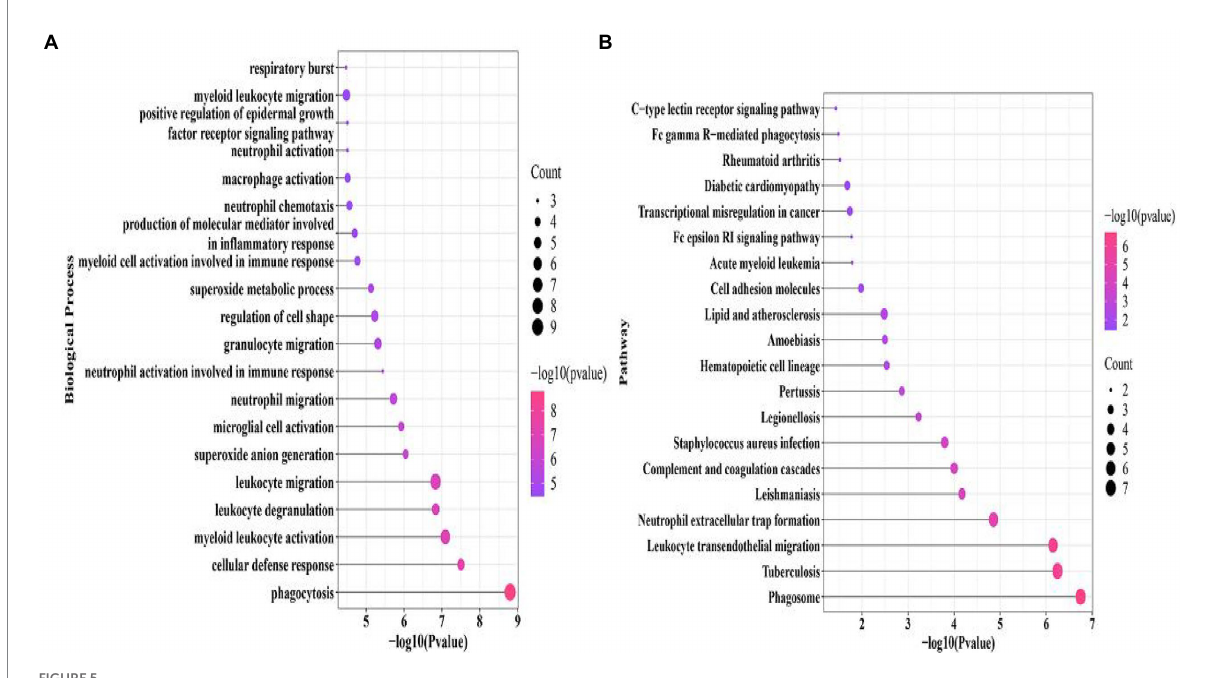
FIGURE 5 Cross-talk gene significant enrichment of biological processes (A) and pathway (B) .